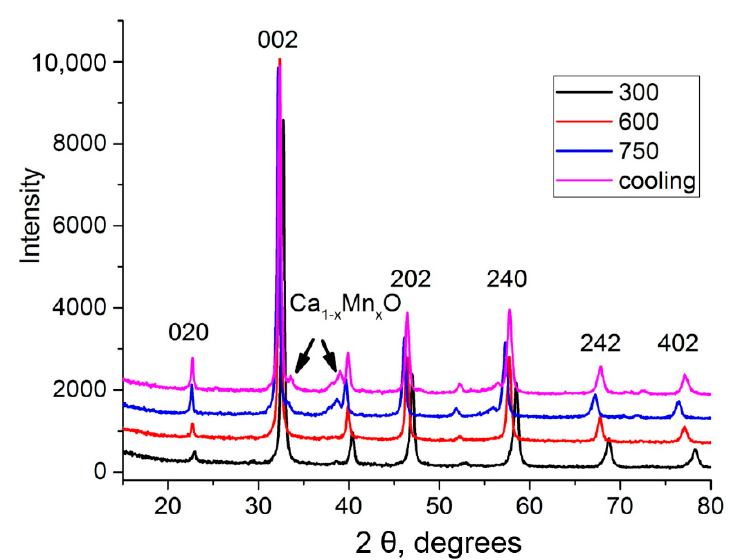
Figure 7. In situ XRD patterns of La 0.5 Ca 0.5 Mn 0.5 Fe 0.5 O 3 in He flow heating. Magenta line is cooling to room temperature. Table 3. Unit cell parameters for the La 0.5 Ca 0.5 Mn 0.5 Fe 0.5 O 3 in He flow heating.